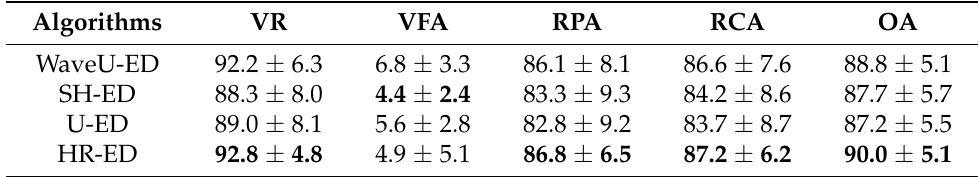
Table 2. Comparison of different singing voice separation methods for VME on MIREX05